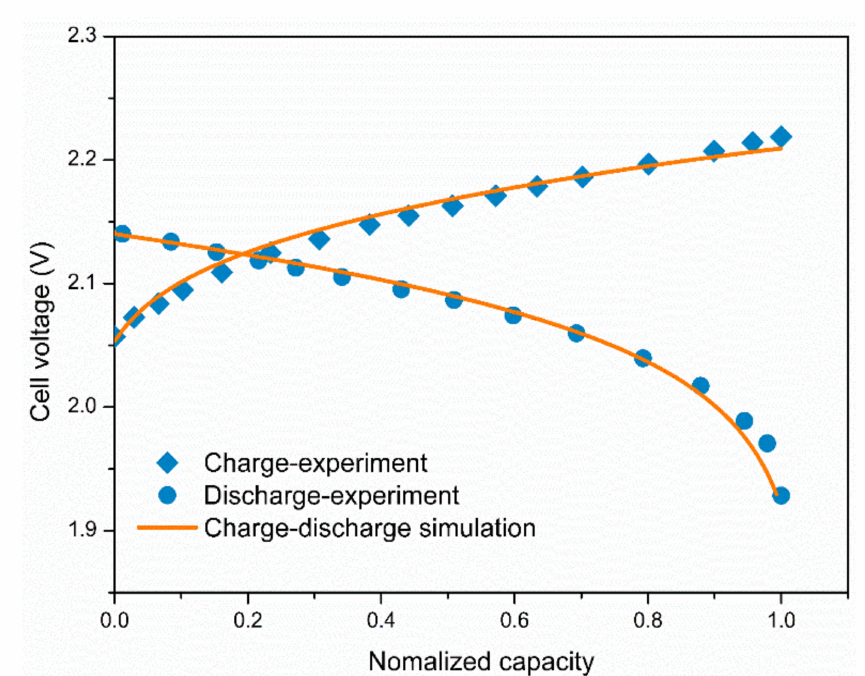
Figure 3. Validation of the present model with experimental data from [32]. Electrolyte: 100 mM V(acac) 3 in 500 mM TEABF 4 ; membrane: microporous separator (Daramic 175); flow rate: 25 mL min − 1 ; current density: 10 mA cm − 2 ; temperature: 300